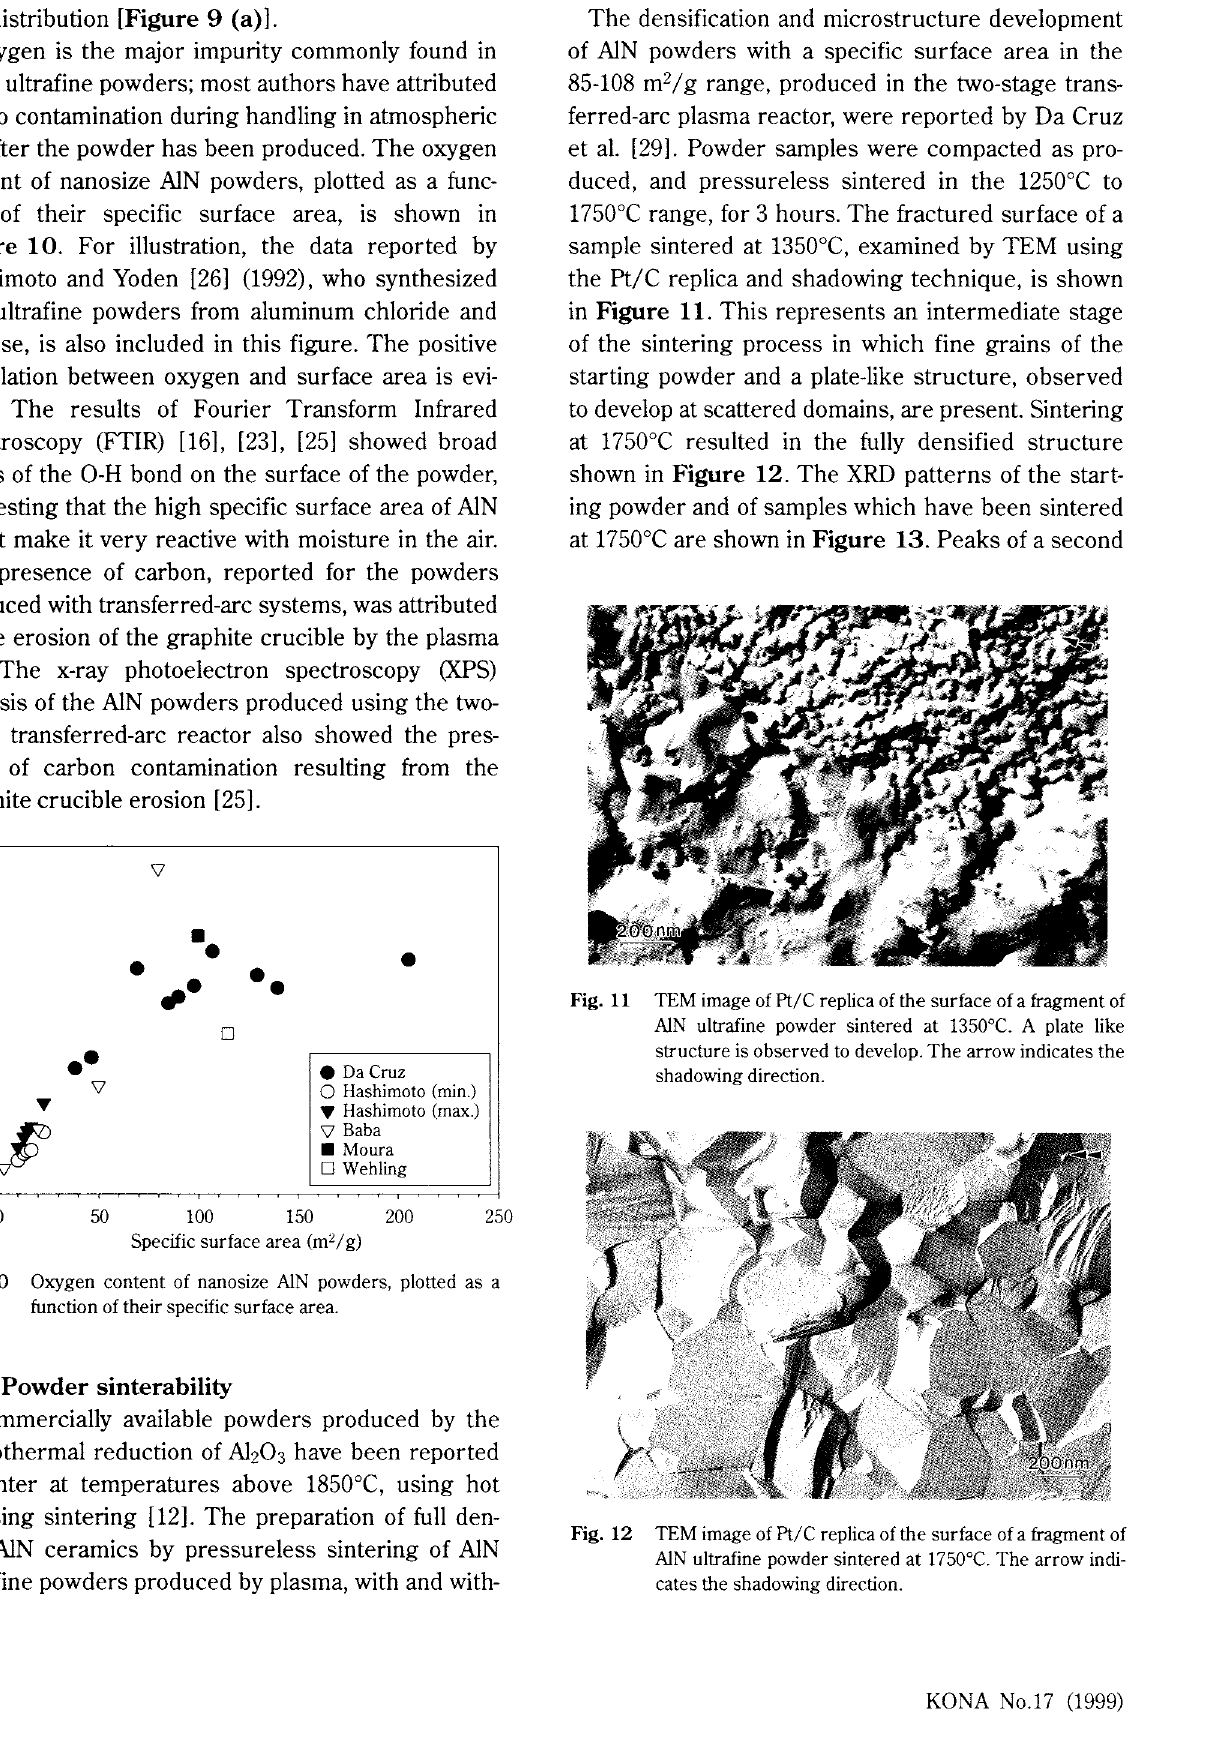
Fig. 12 TEM image of Pt/C replica of the surface of a fragment of AIN ultrafine powder sintered at 1750°C. The arrow indi cates the shadowing